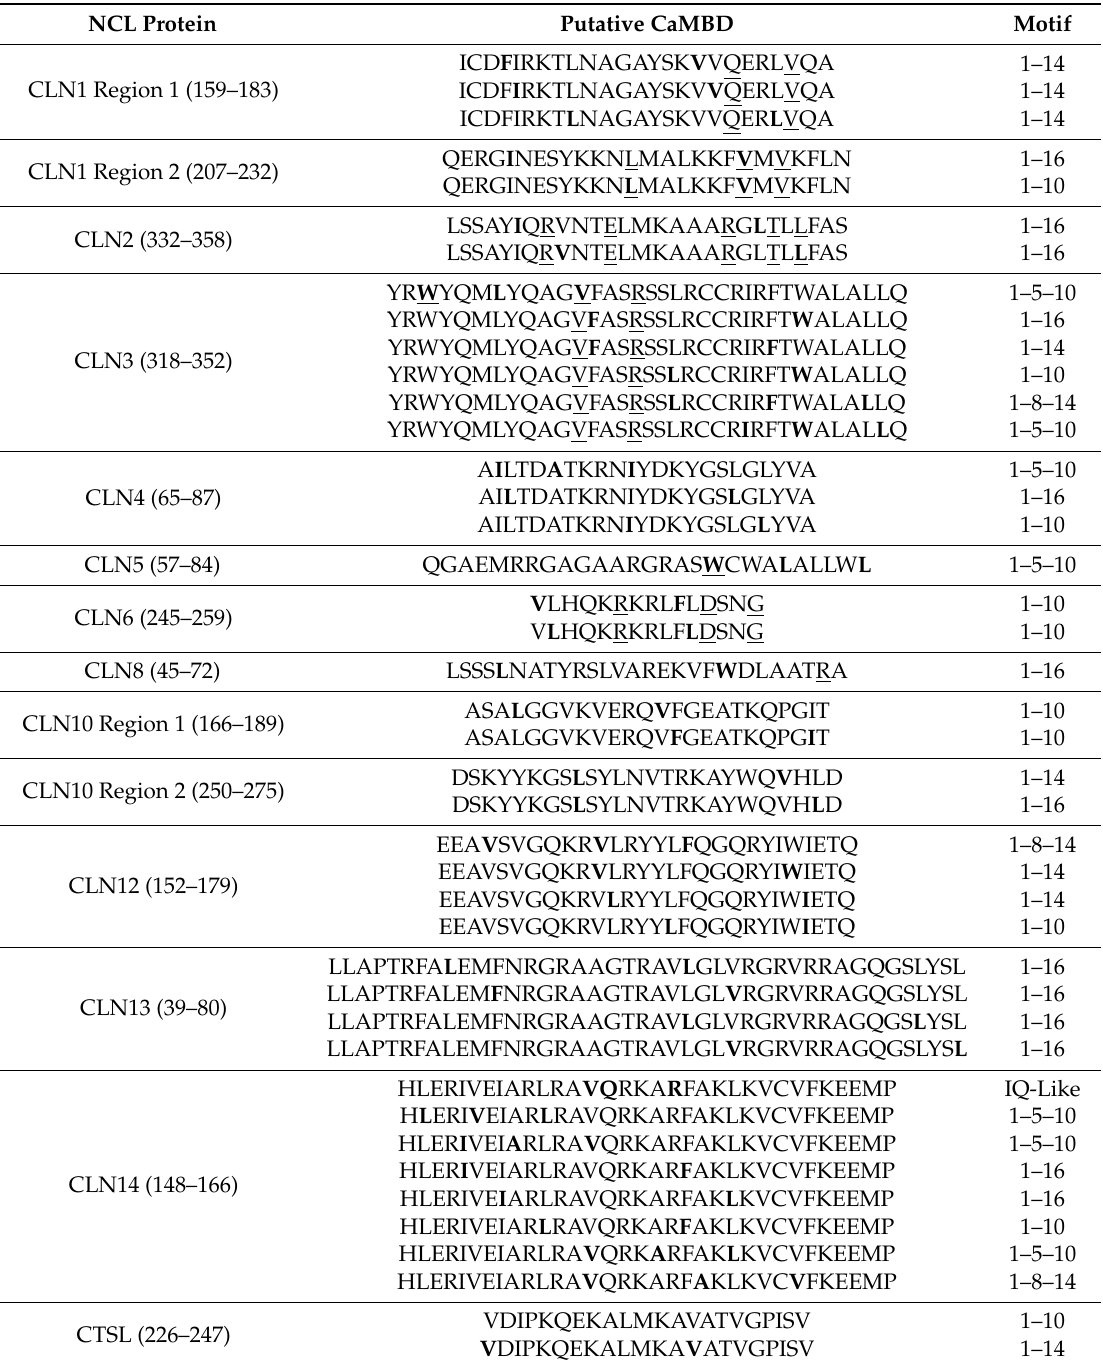
List of putative calmodulin-binding domains in proteins linked to neuronal ceroid lipofuscinosis. The Calmodulin Target Database (http://calcium.uhnres.utoronto.ca/ctdb/ctdb/ home.html) was used to reveal putative calmodulin-binding domains (CaMBDs) in proteins linked to neuronal ceroid lipofuscinosis (NCL). Numbers indicate the amino acid positions where the domain is predicted to be present for each protein. Motifs were identified based on known canonical CaM-binding motifs, which are listed in Table 1. Bolded residues mark the amino acids, which are required for the identified motif. Underlined residues represent the residues where NCL patient mutations are also present in the CaMBD. CLN7 and CLN11 are excluded, since they lack CaMBDs; however, the CaMBD within cathepsin L (CTSL) is